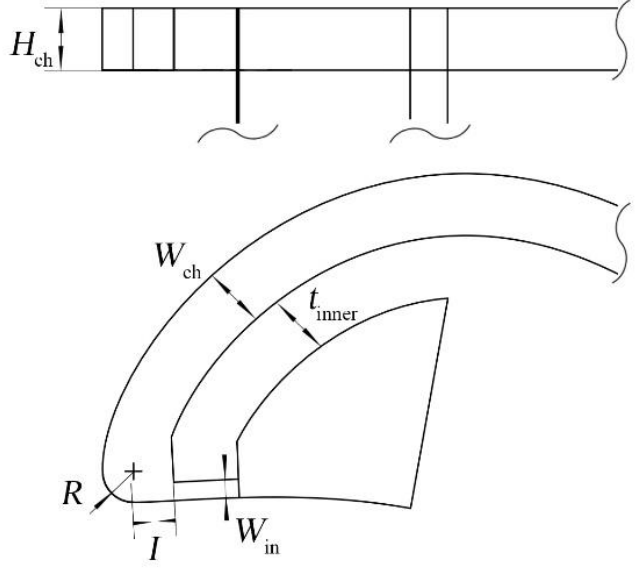
Figure 4. Details of wall jet cooling structure.